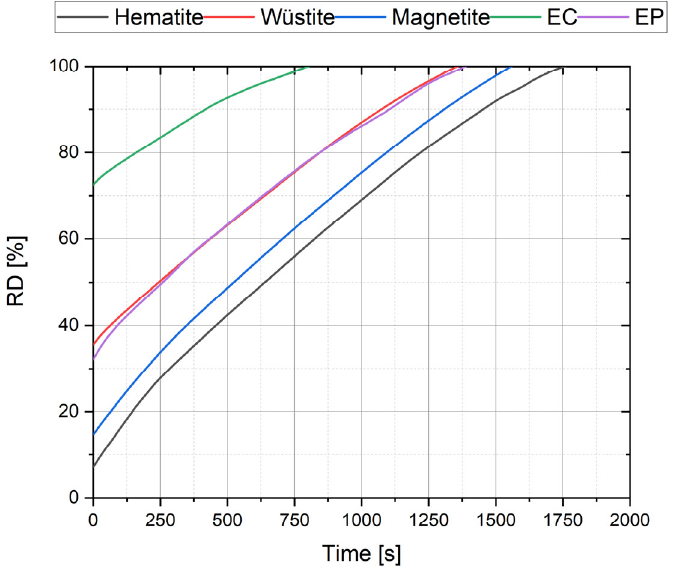
Figure 7. Total reduction degree (RD) during hydrogen injection for various charged materials based on pure Fe 2 O 3.